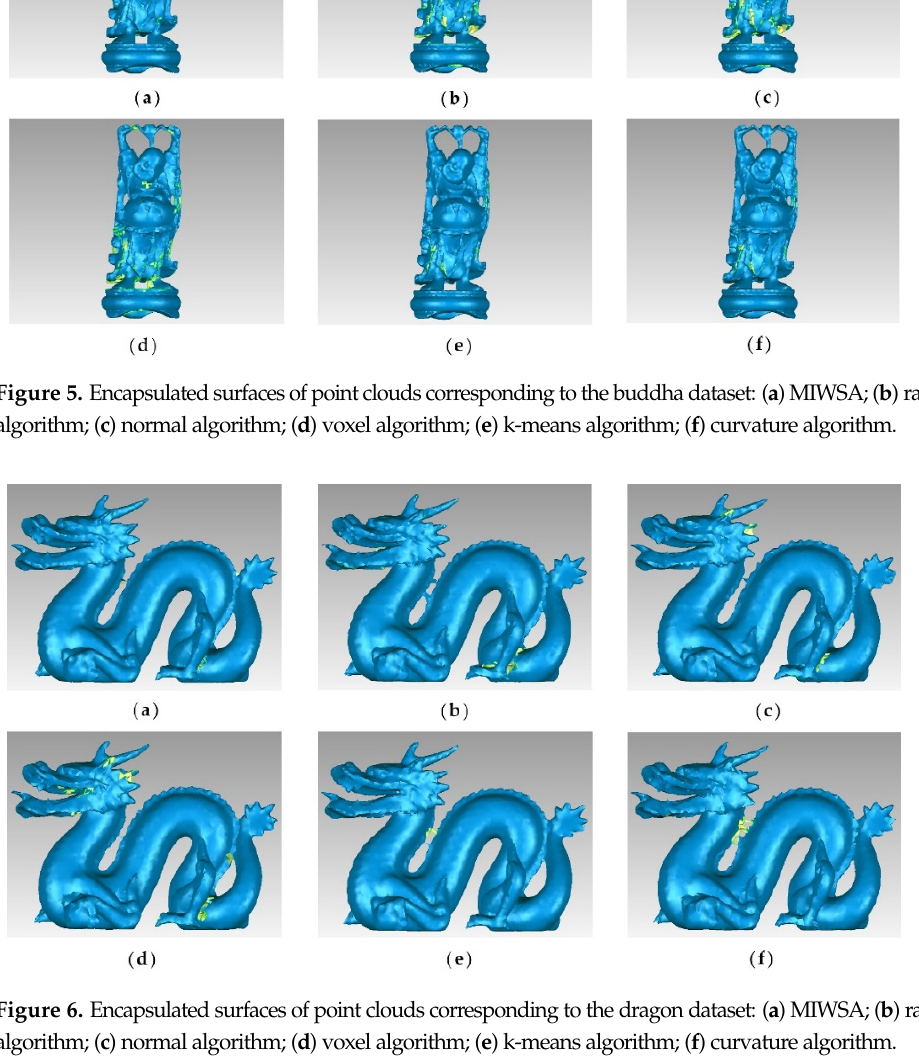
Figure 6. Encapsulated surfaces of point clouds corresponding to the dragon dataset: ( a ) MIWSA; ( b ) random algorithm; ( c ) normal algorithm; ( d ) voxel algorithm; ( e ) k-means algorithm; ( f ) curvature algorithm.